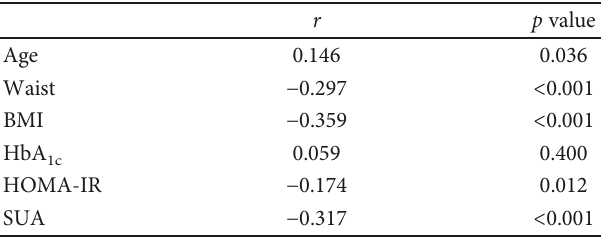
Table 4: Correlation analysis of total testosterone and other indicators.